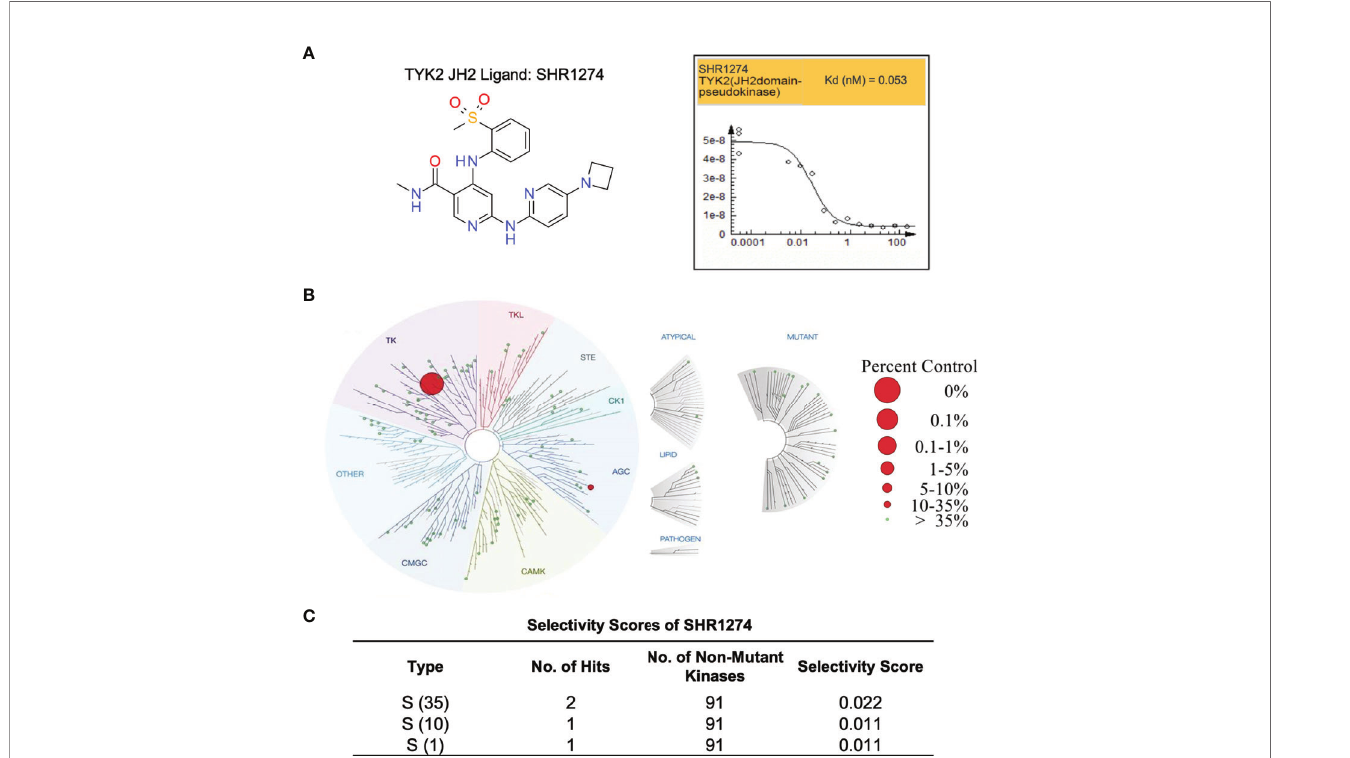
FIGURE 6 | TYK2 pseudokinase small molecule ligand is highly selective across a multi-kinaseScan panel. (A) Chemical structure of TYK2 JH2 ligand, SHR1274 and representative dose-response curves of SHR1274 binding to TYK2 JH2 pseudokinase and JH1 kinase domains assessed by DiscoveX KdELECT Competition Binding Assay. The fi gures are representative of the technical duplicates in the experiment. Dissociation constants (Kds) for test compound-JH1 or -JH2 domain interactions are calculated by measuring the amount of isolated JH1 or JH2 protein segments captured on the solid support as function of the test compound concentrations. (B) Kinase selectivity pro fi le of SHR1274 at 1 µM across 98 kinases in the kinome screening panel, with kinase binding inhibited by > 99% (large red circles) or 65-90% (small red circles). Screening “ hits ” are identi fi ed by quantifying the amount of kinase captured in test compounds versus control by using quantitative PCR that detects the associated DNA label; (C) Selectivity scores at S (1): > 99% competition, S (10): 90-99% competition or S (35): 65-90%